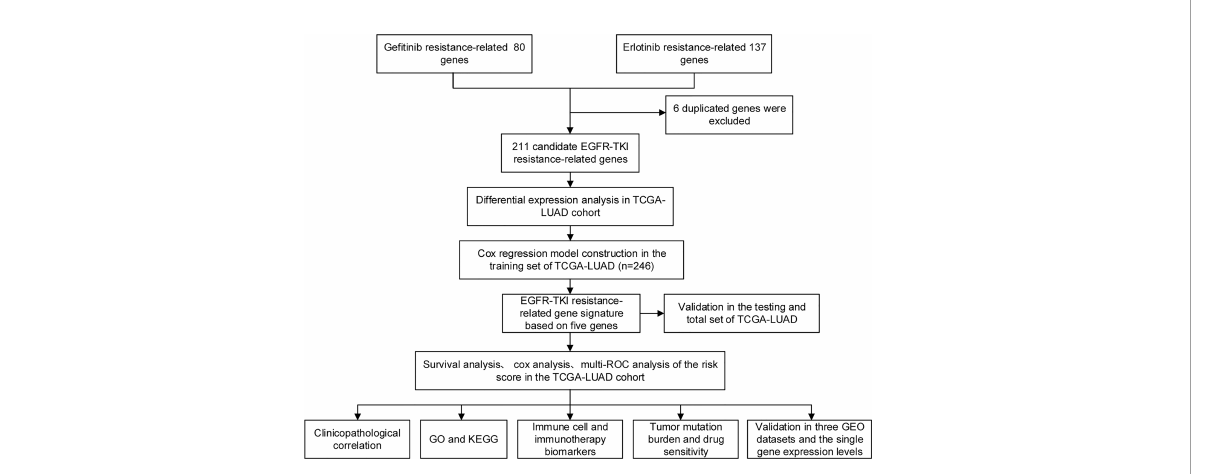
FIGURE 1 The fl ow of this study. From GEO databases, genes associated with EGFR-TKI resistance were identi fi ed and subsequently studied in the TCGA- LUAD cohort. Cox regression analysis was used to establish the risk model. Based on the computed risk scores of the risk model, TCGA-LUAD patients were divided into high-risk and low-risk groups. The differential analyses among the two groups, such as immune cells and immunotherapy response biomarkers, were explored.